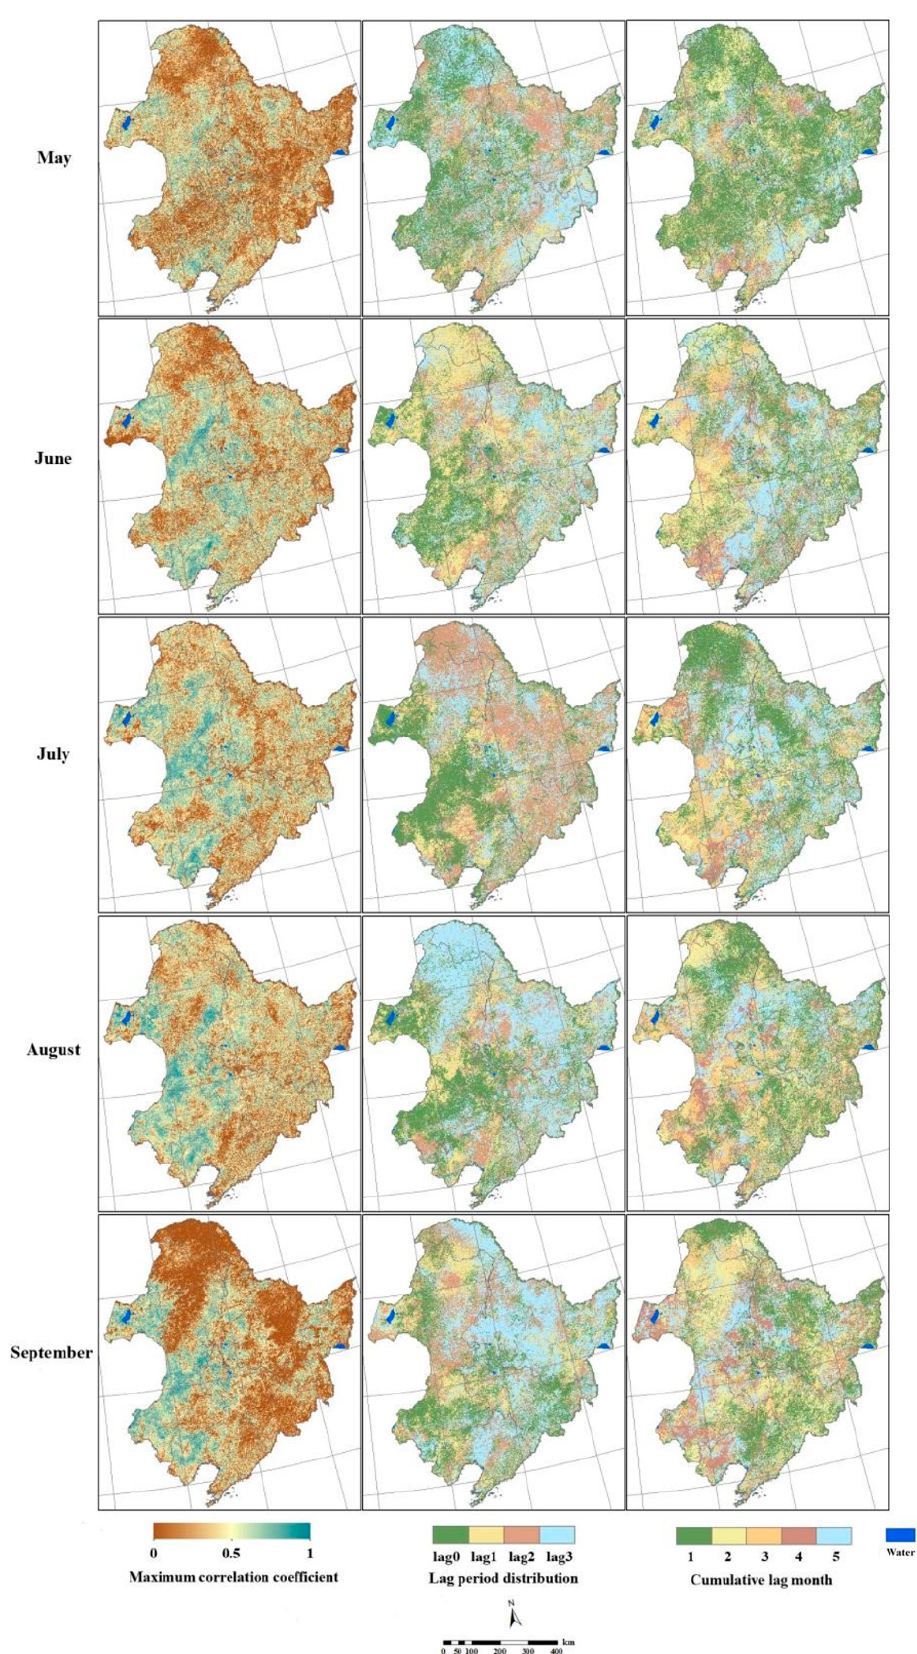
Figure 4. Lag responses of the NPP to the precipitation over Northeast